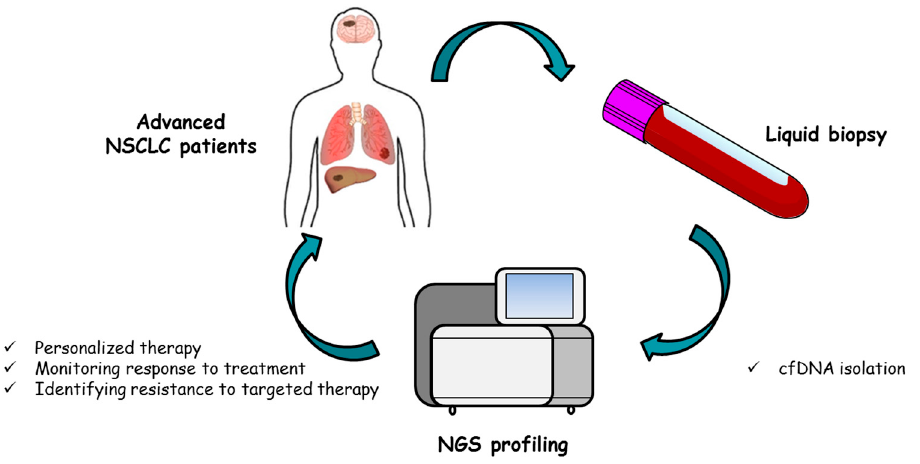
Figure 2. Role of NGS profiling of circulating free DNA in advanced non-small cell lung cancer patients.